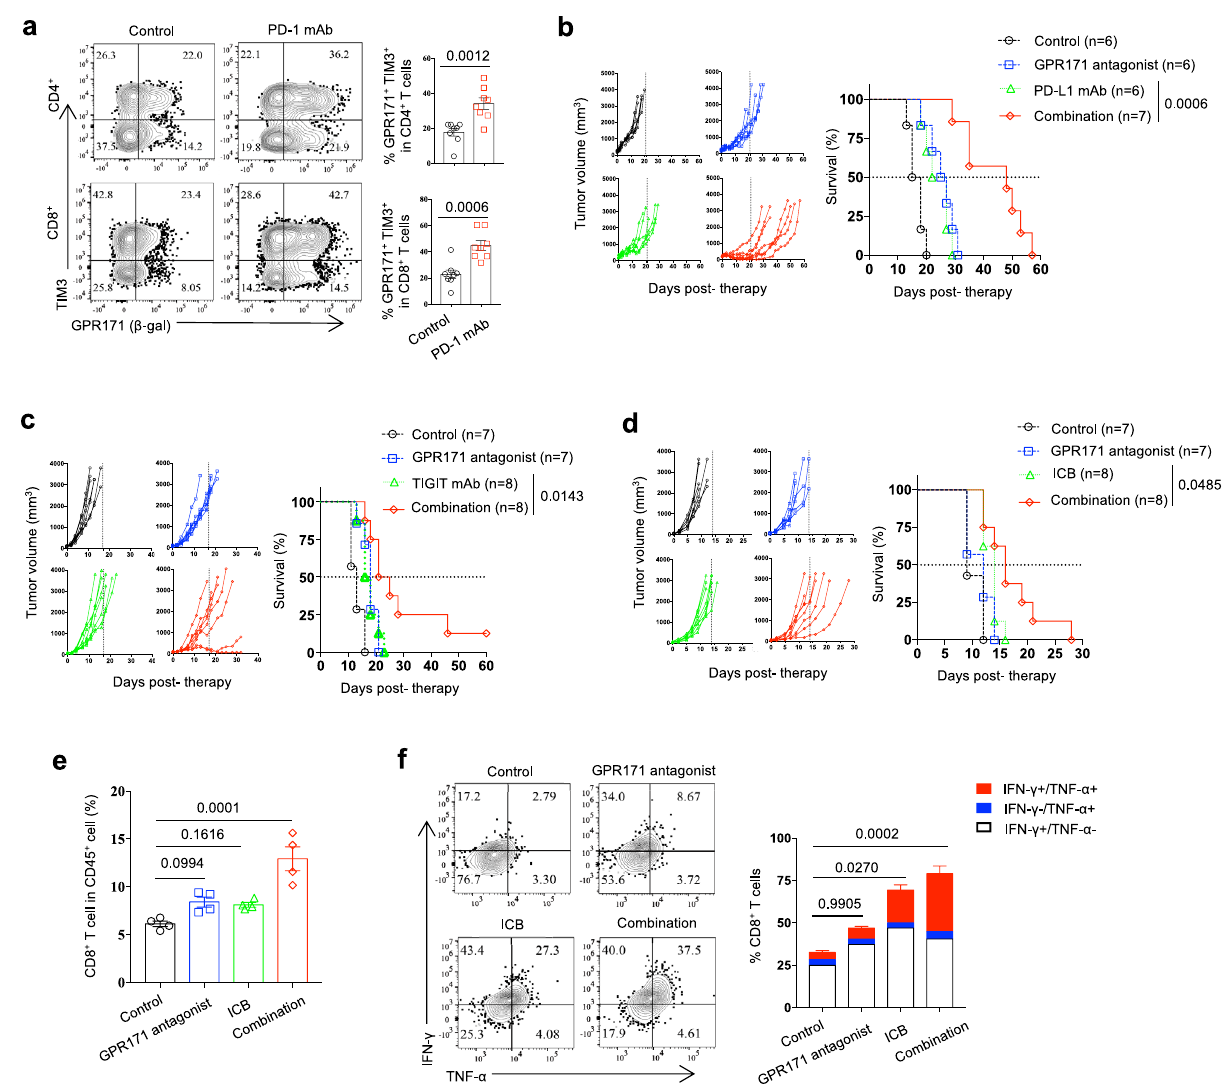
Fig. 6 GPR171 blockade improves therapeutic antitumor effect of ICB. a TILs from MC38 tumors in GPR171 + /LacZ mice under 10 days control or PD-1 mAb treatment were analyzed for TIM3 and GPR171 expression. b Tumor growth and tumor-related survival of MC38-bearing mice under the treatment of PD-1 mAb and GPR171 antagonist were shown. Therapy was started 10 days after tumor inoculation. c Tumor growth and tumor-related survival of CT26- bearing mice under the treatment of TIGIT mAb and GPR171 antagonist were shown. Therapy was started 7 days after tumor inoculation. d – f Tumor growth and survival of B16F10-bearing mice treated with ICB (PD-L1 + CTLA-4 mAbs) together with GPR171 antagonist were shown ( d ). Therapy was started 7 days after tumor inoculation. 14 days after therapy, single-cell suspensions were prepared to determine the percentages of intratumoral CD8 + T cells ( e ) and cytokine- producing CD8 + T cells ( f ). In Figure b , c , and d , the dash line in each left panel indicates the date when all control mice were dead due to tumor burden. The dash line in each right panel shows median survival. GPR171 antagonist was administrated three times a week for up to total nine times while antibody was injected twice per week for up to total six times. a n = 8 biologically independent samples. b n = 6 (control, GPR171 antagonist and PD-L1 group) and n = 7 (combination group). c n = 7 (control, GPR171 antagonist and TIGIT group) and n = 8 (combination group). d n = 7 (control and GPR171 antagonist group) and n = 8 (ICB and combination group). e and f n = 4 biologically independent samples. Statistical signi fi cance was determined by One-way ANOVA for e and f , two-tailed Student ’ s t -test for a , or Log-rank test for b , c and d . Unless otherwise denoted, values